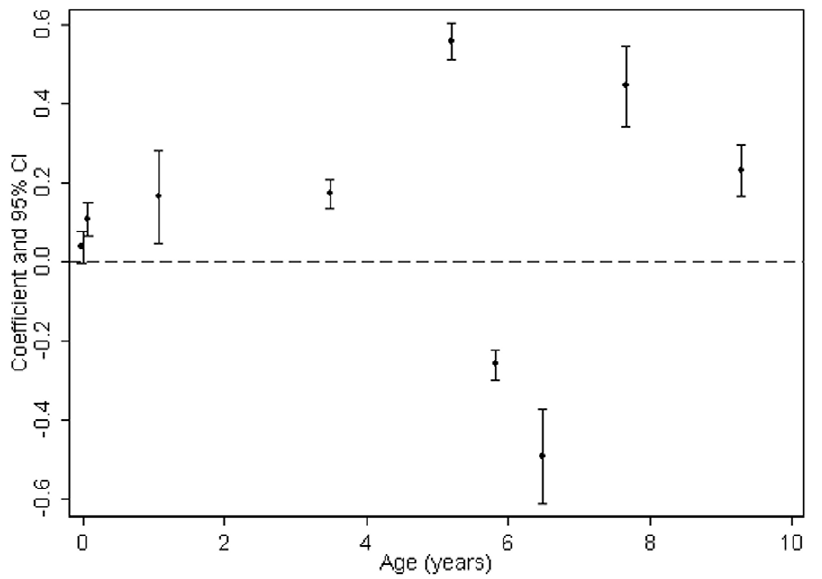
Figure 3. Boys Coefficients and 95% confidence intervals from standardised linear regressions of DXA-assessed fat mass at age 15 on PI/BMI trajectories (age in years along x-axis is the mid-point of PI/BMI change periods; coefficients are adjusted for confounders and previous PI/BMI changes, i.e. Model 3).